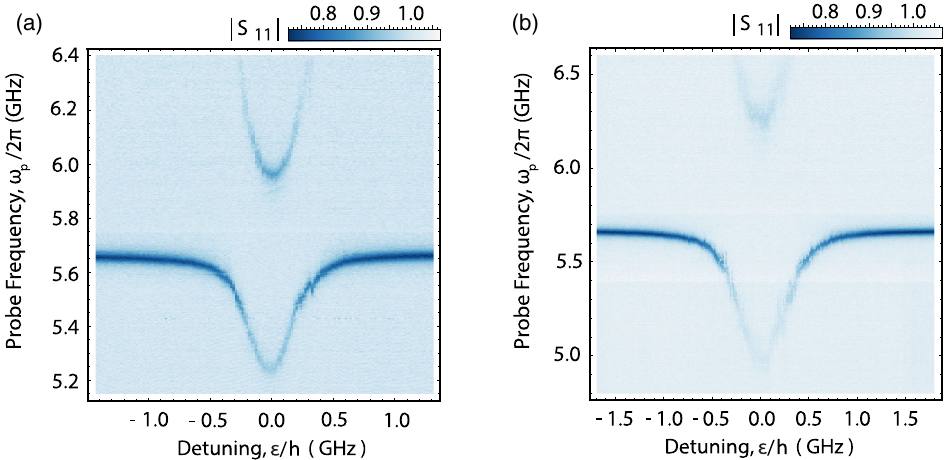
FIG. 13. Response of the Josephson-junction array resonator reflectance amplitude j S 11 j versus DQD detuning ϵ in correspondence of a DQD configuration characterized by parameter (a) η ∼ 0 . 50 (cid:3) 0 . 14 and (b) η ∼ 0 . 72 (cid:3) 0 . 08 . Data are already reported in Figs. 5(b) and 11(b).